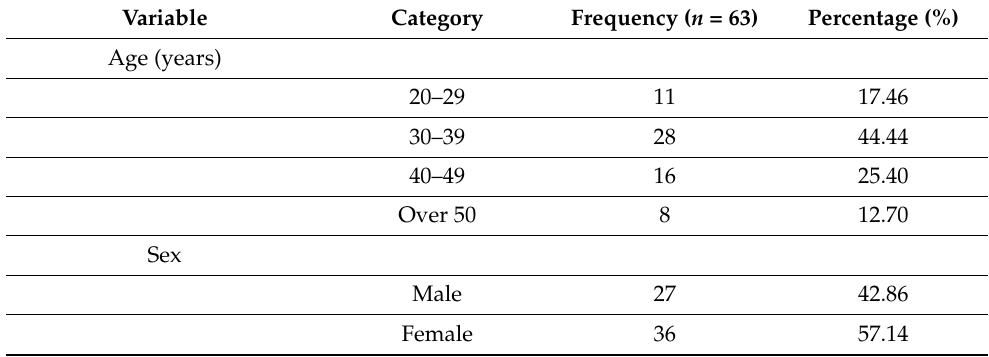
Table 2. Socio-demographic characteristics of Focus group discussions’